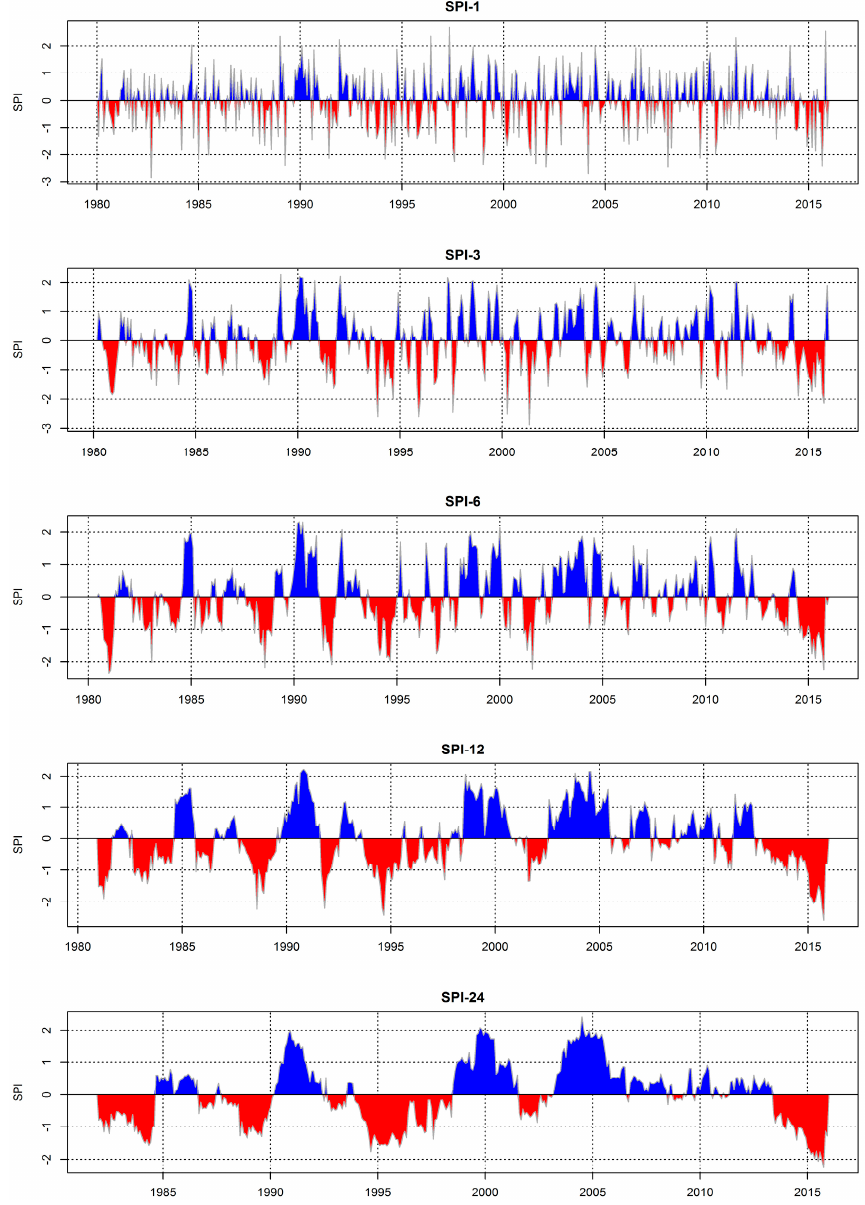
Figure 4. Evaluation of SPI drought index on different time scale.